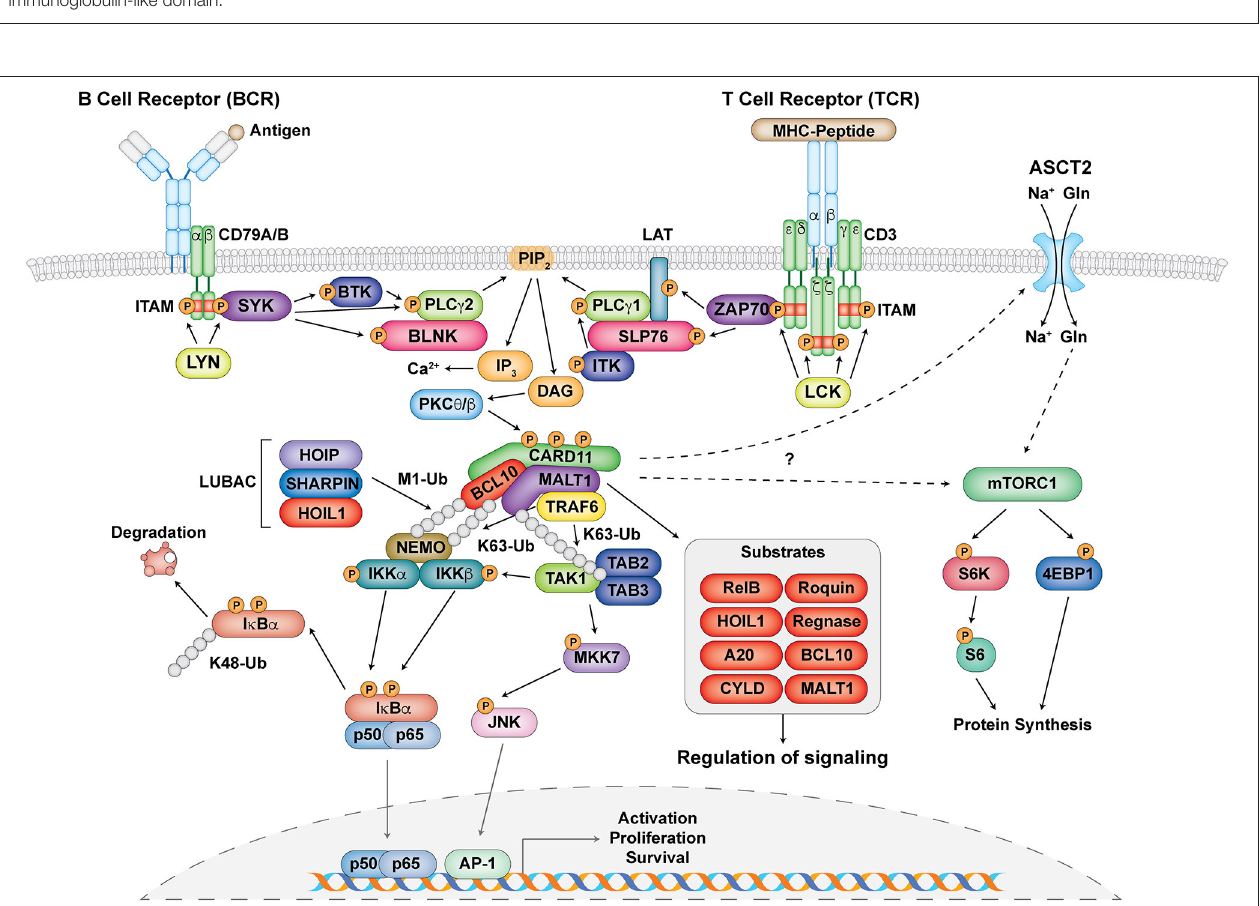
FIGURE 2 | The central role of the CBM complex in BCR- and TCR- signaling. Schematic representation of proximal antigen receptor signaling events in the BCR and TCR, activation and assembly of the CBM complex, and downstream targets and effects of CBM activation. Gray circles represent ubiquitin chains.